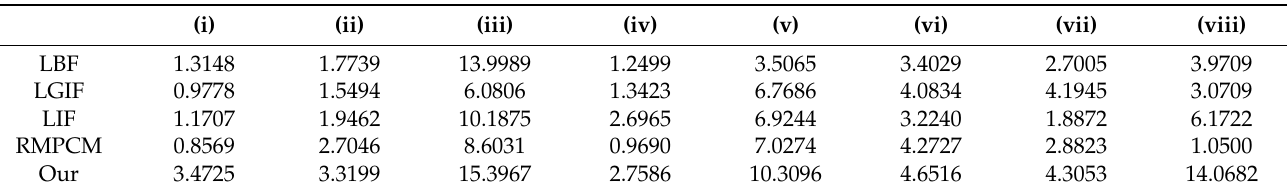
Table 5. The DR results of LBF, LGIF, LIF, RMPCM, and our method in Figure